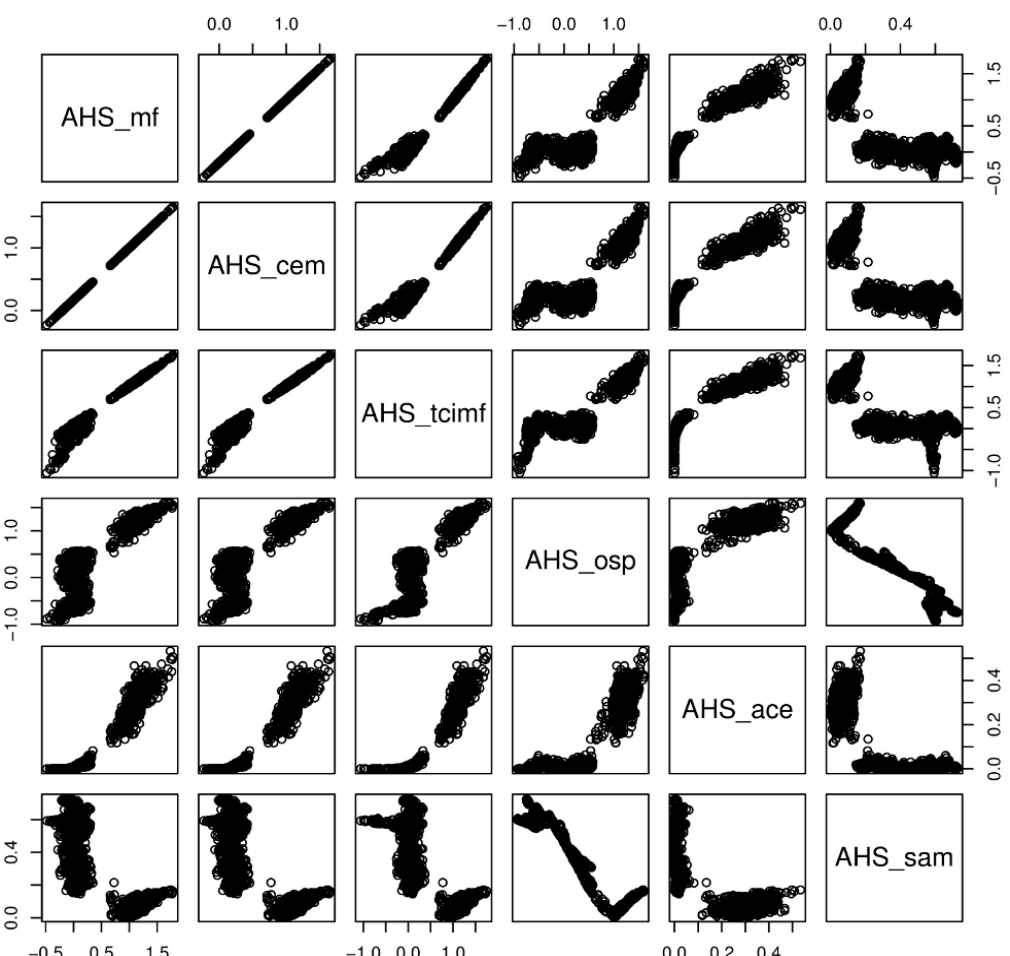
Figure 7. Bivariate scatter plots of rule-image values for each detection algorithm in the AHS image. SAM = Spectral Angle Mapper, MF = Matched Filter, CEM = Constrained Energy Minimization, ACE = Adaptive Coherence Estimator, OSP = Orthogonal Subspace Projection, TCIMF = Target-Constrained Interference-Minimized Filter.